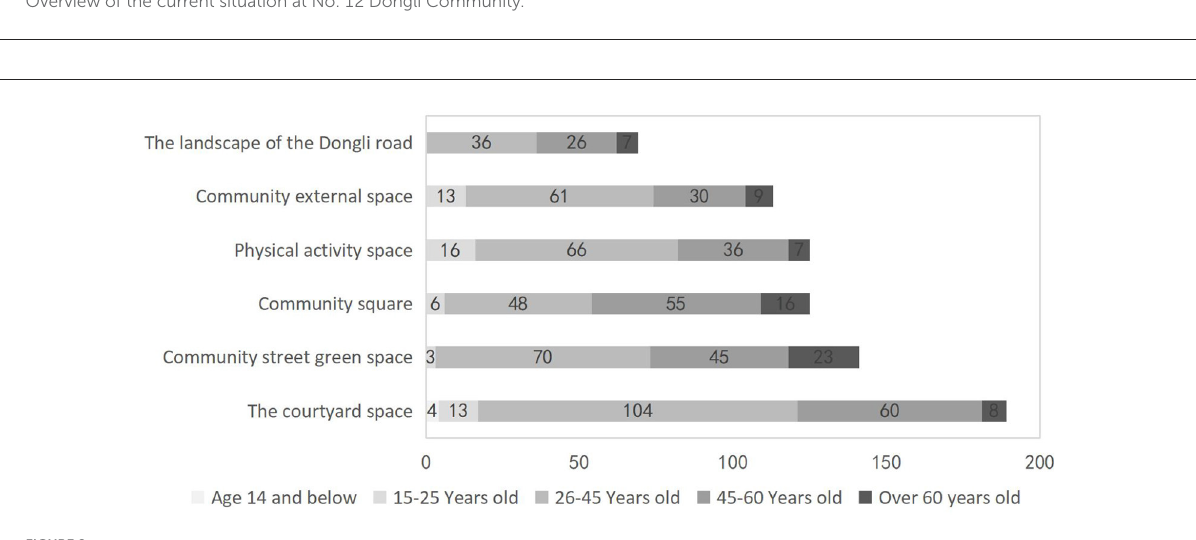
FIGURE2 Survey on outdoor space preference of residents in Dongli